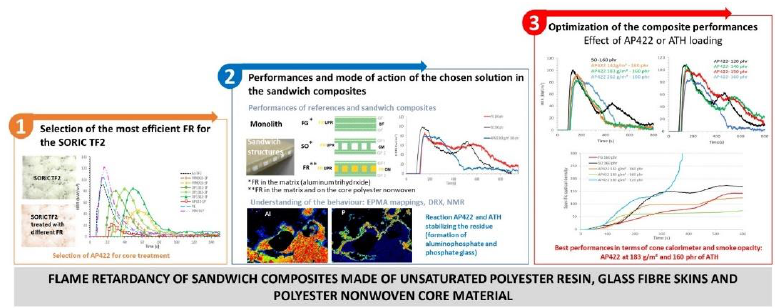
Figure 1. Graphical abstract showing the layout of the paper and main conclusions.